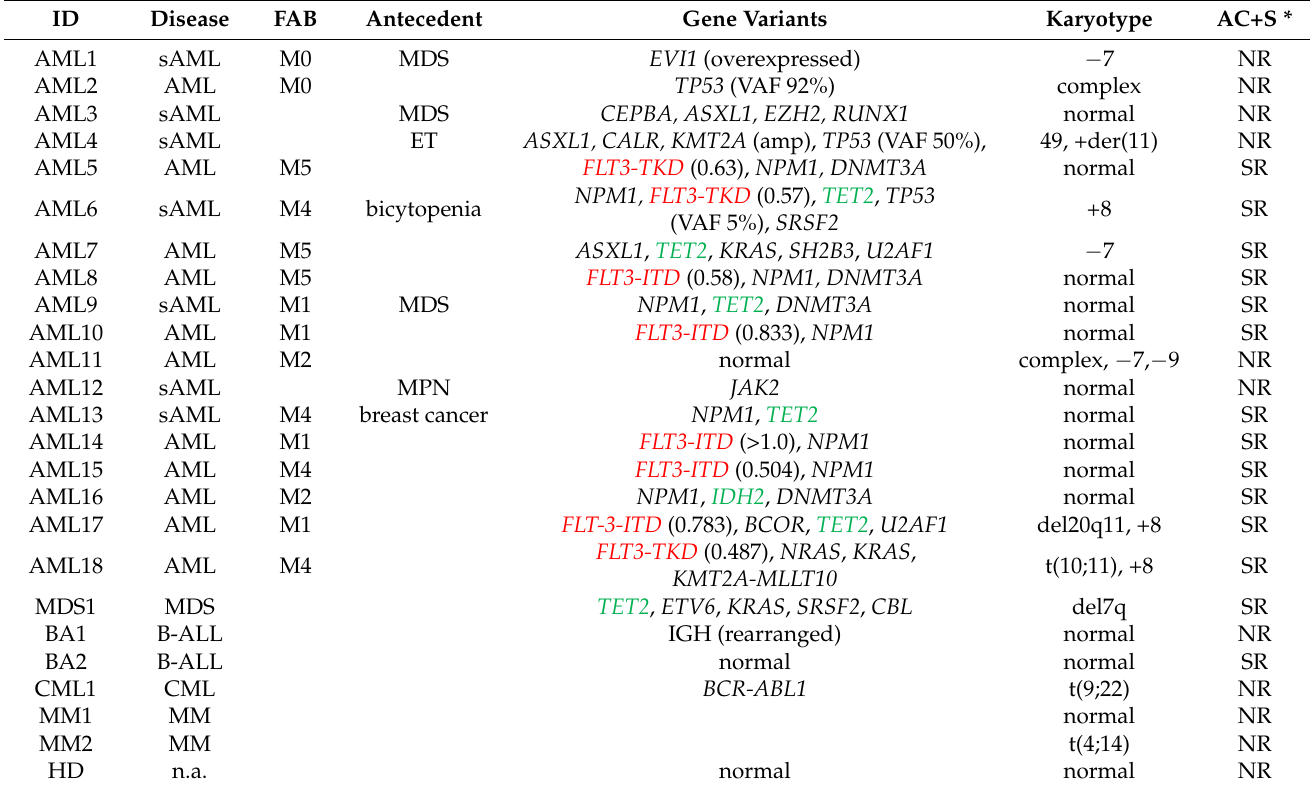
Table 3. Clinical characteristics of hematological patient samples.